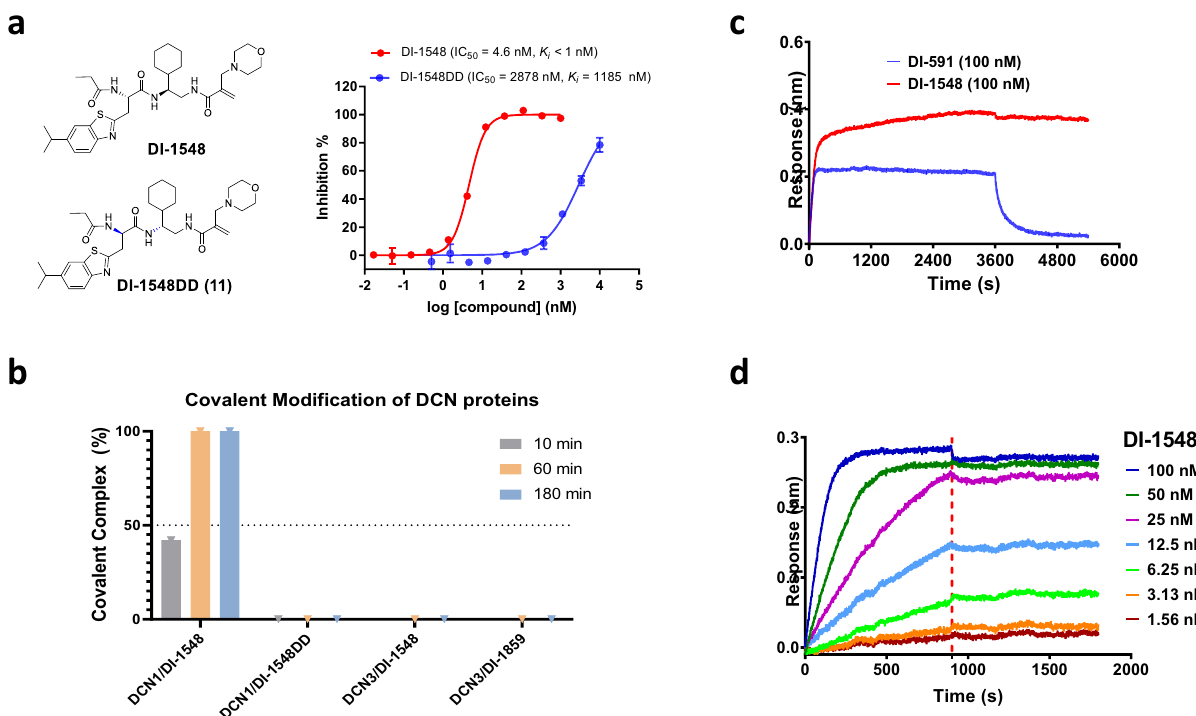
Fig. 5 Characterization of the selectivity of DI-1548 and DI-1859. a Chemical structures and competitive binding curves of DI-1548 and DI-1548DD. b Percentage of the formation of covalent complex between the indicated compounds and proteins based on the intact ESI mass spectrometric analyses. The mass spectra are provided in Supplementary Figs. 14 – 17. c Kinetic binding sensorgrams of DI-591 and DI-1548. Interferometric responses increased upon the binding of compounds to the DCN1 protein immobilized on the super streptavidin (SSA) biosensor surfaces. Signals were monitored and recorded every second while sample plates being continuously shaken at 1000 RPM to eliminate mass transport effect. d Kinetic binding sensorgrams of DI-1548 with concentrations ranging from 1.56 to 100 nM and steady state fi tting of the equilibrium responses vs compound concentrations based on 1:1 binding model. The representative data from at least two independent experiments were shown for a , c , and d . Source data are provided as a Source Data fi